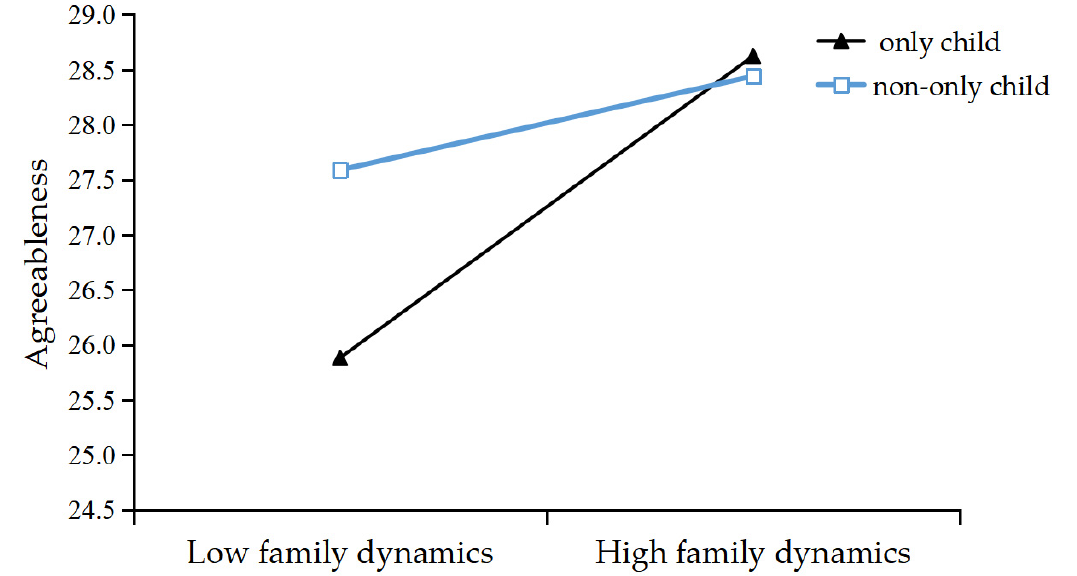
Figure 3. The conditional effect between family dynamics and agreeableness (N = 963). To further understand the moderation effect of only-child status on the path between family dynamics and agreeableness, a conditional indirect effect analysis was conducted at two aspects of the only-child and the non-only-child.